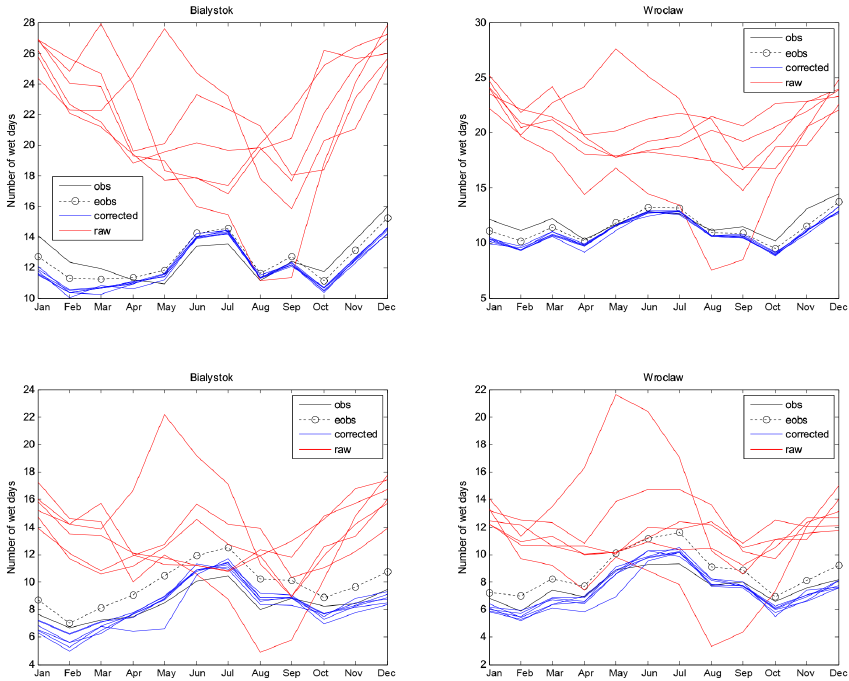
Figure 6. Comparison of mean monthly number of wet days with the minimum rain threshold values set to 0.1mm (upper panels) and 1mm (lower panels) for the uncorrected RCM data (raw), calculated over the reference time period for two grid cells located close to Białystok (NE Poland) and Wrocław (SW Poland). The black continuous line denotes observations from the meteorological stations, black dashed lines denote observations from the E-OBS reanalysis, red lines denote uncorrected precipitation values from the RCMs, and blue lines denote corrected RCM precipitation values.